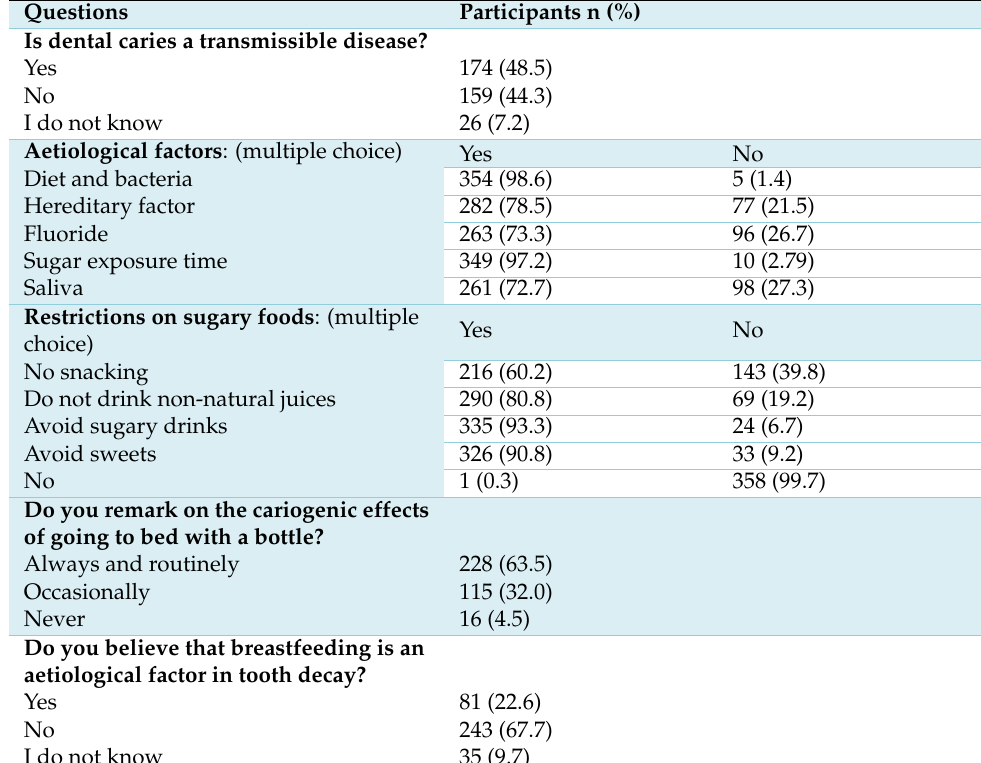
Table 3. Dental caries and aetiological